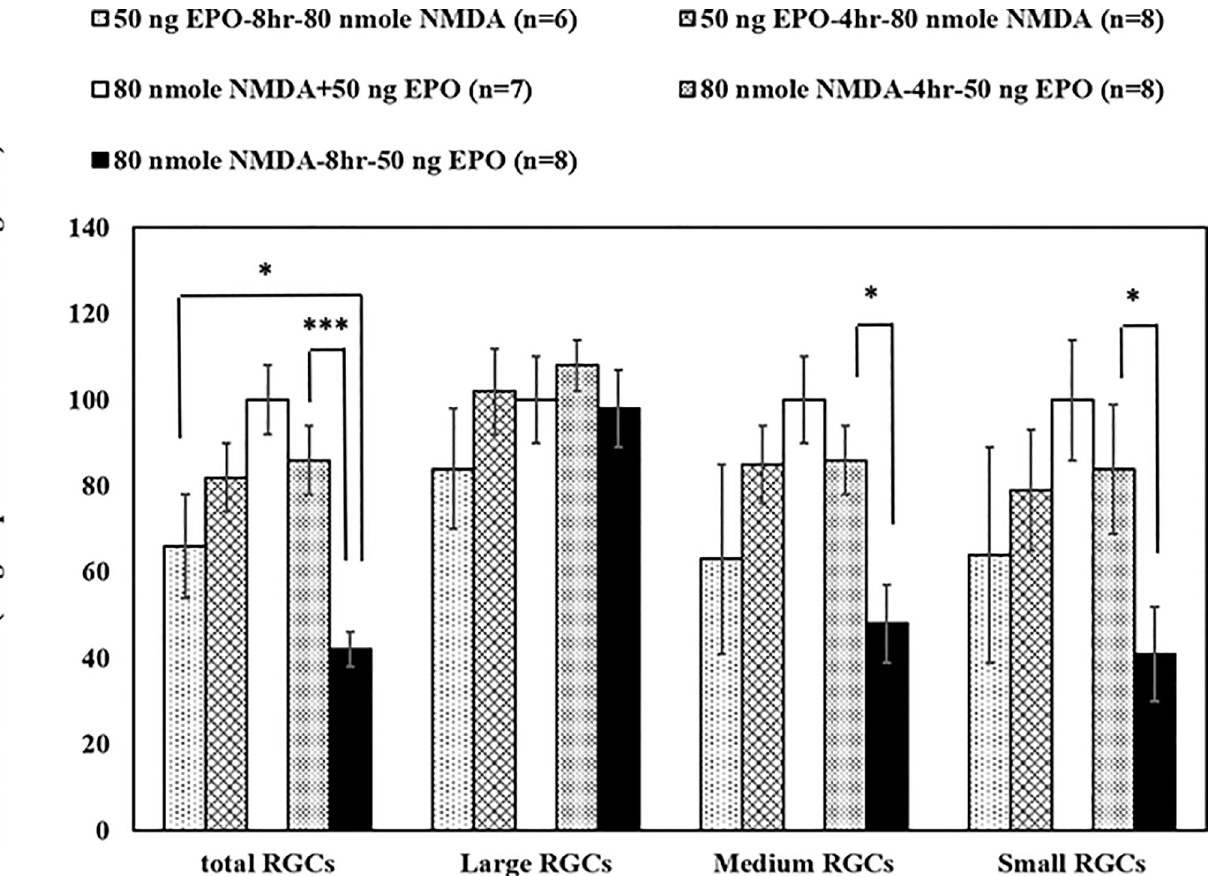
Fig 1. The survival rates of RGCs was determined at different administrating time of EPO by retinal flat mount analysis: The dose of 50 ng EPO was administered pre/co/post injecting intravitreally with 80 nmoles NMDA. The survival rates were normalized with the EPO co-treated groups (80 nmoles NMDA + 50 ng EPO), which is setup for 100% survival rate of RGCs. The survival rates of total, large, medium and small RGCs were determined under different administrating time (pre-treated: 50 ng EPO-4hr-80 nmoles NMDA and 50 ng EPO-8hr-80 nmoles; post-treated: 80 nmoles-4hr-50 ng EPO and 80 nmoles-8hr-50 ng EPO) after 7 days. The co-treated and earlier post-treated groups (0 and 4 hours) had a higher survival rate as compare with the late post-treated group (8 hours) ( � p < 0.05; �� p < 0.01; ��� p < 0.001 compared with 80 nmoles NMDA-8 hr-50 ng EPO group) (n = 6–8).